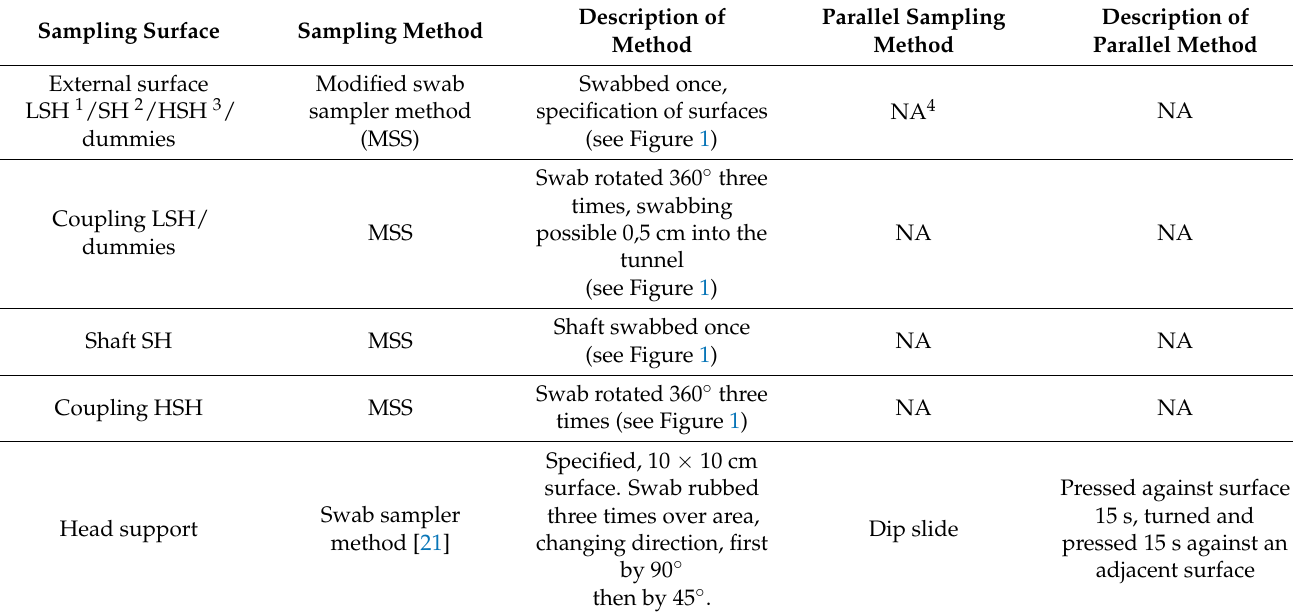
Table 2. Description of sampling methods for handpieces and the head